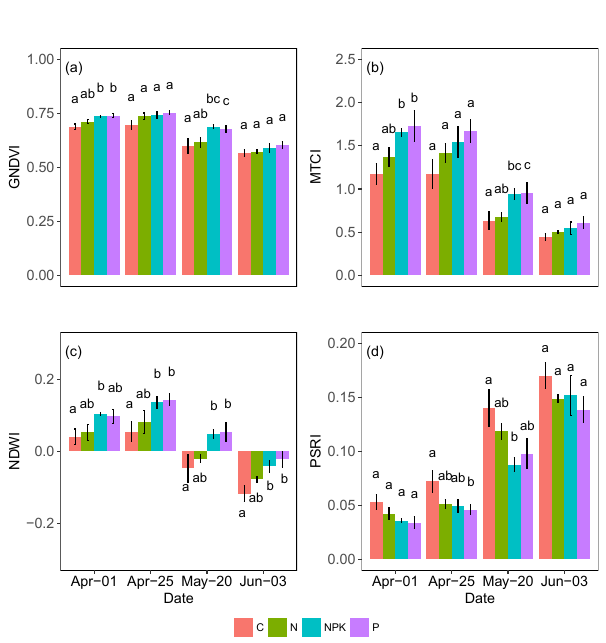
Figure 6. Average values of several vegetation indices retrieved from reflectance measurements of herbaceous plots undergoing dif- ferent fertilization treatments. Vertical bars represent standard er- rors. Different letters indicate significant differences among treat- ments within the same date ( P < 0 .